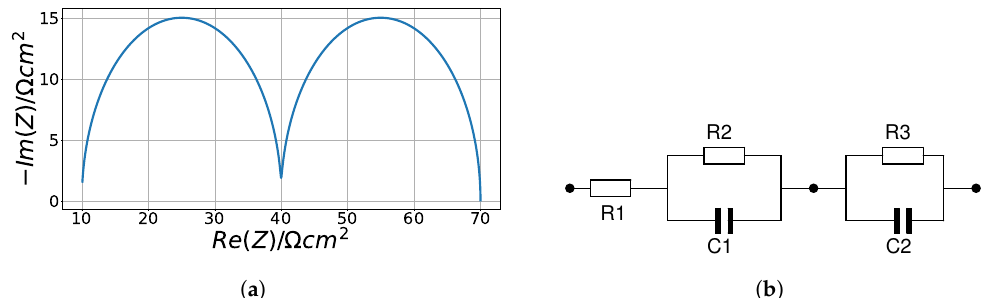
Figure 7. Double ZARC characteristic and its equivalent circuit. ( a ) Z characteristic; ( b ) Equivalent circuit.